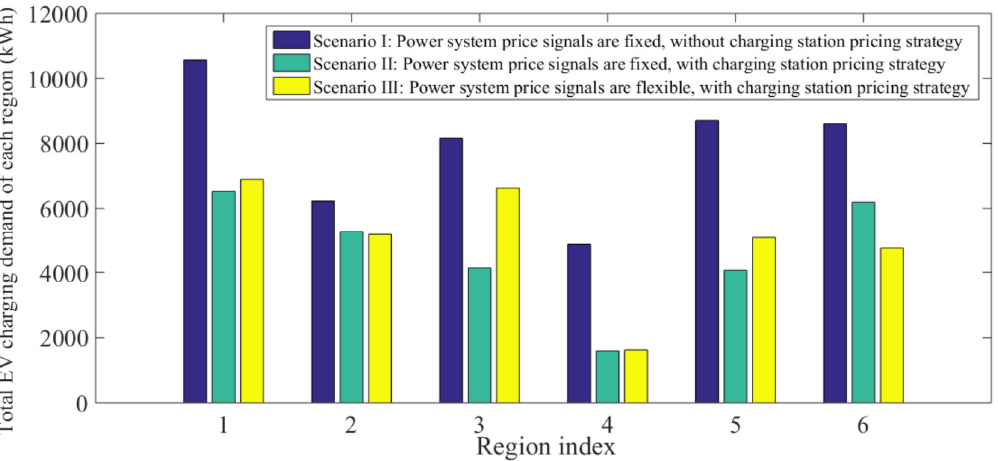
Figure 13. Total charging demand of each region under various scenarios in the presence of PHEVs.